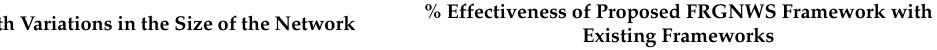
Table 9. The average % effectiveness of the proposed novel framework for the average hop distance to the sink metric with variations in the network